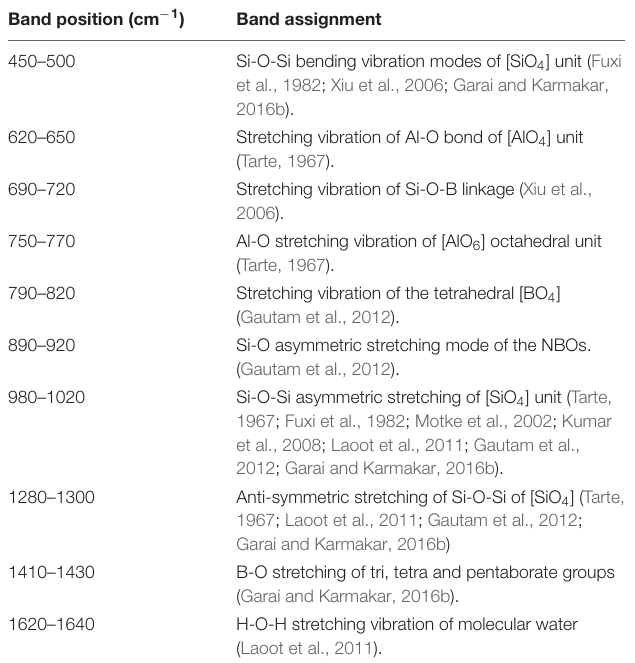
TABLE 4 | Fourier transform infra-red transmission bands and respective assignments for K 2 O-MgO-Al 2 O 3 -B 2 O 3 -SiO 2 -F glasses with and without K 2 Cr 2 O 7